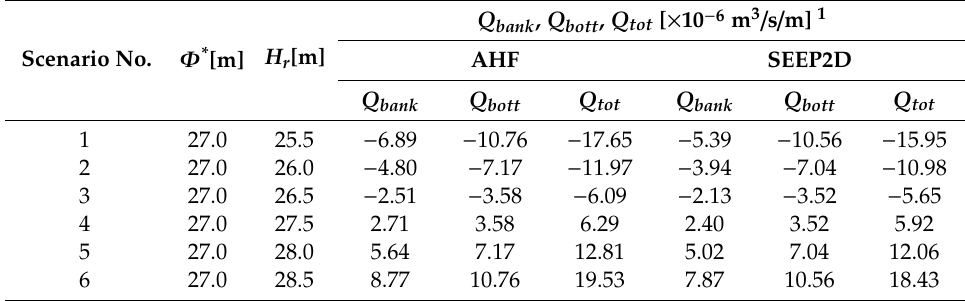
Table 3. One side Q bank , Q bott , and Q tot assessed by means of the analytical (AHF) and numerical (SEEP2D) models (with assumption of no flow between P.3–P.4 and P.1–P.3).